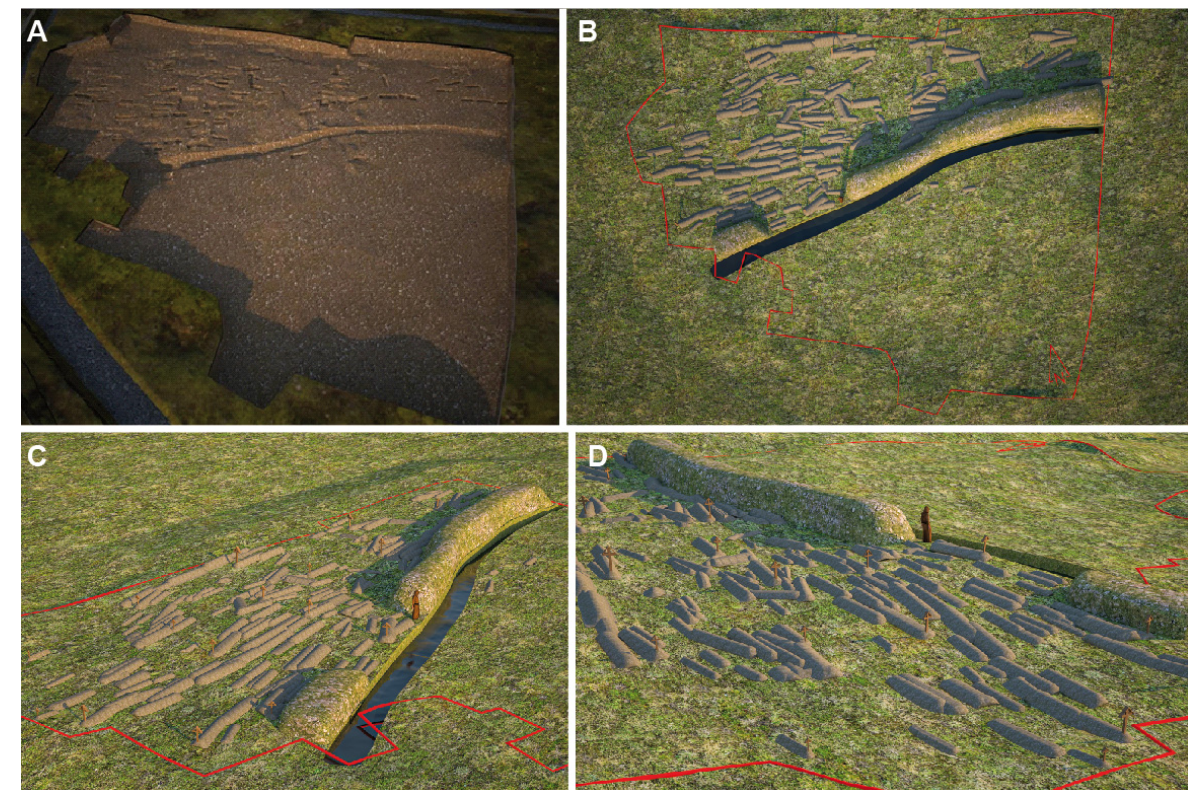
Figure 9. ( A ) The “bottom of form” DTM. The graves are concentrated north of the border ditch; ( B ) Zenithal and northwest view of the “funeral mound” DTM graves of different orientations are concentrated north of the bordering ditch; ( C , D ) View from the west and northwest of the burial mound DTM.